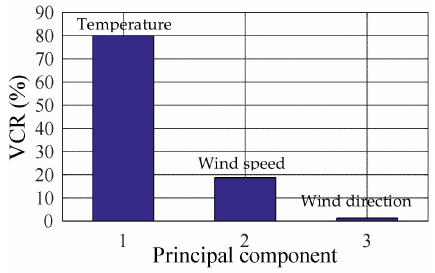
Figure 7. Variance contribution rates of di ff erent components.